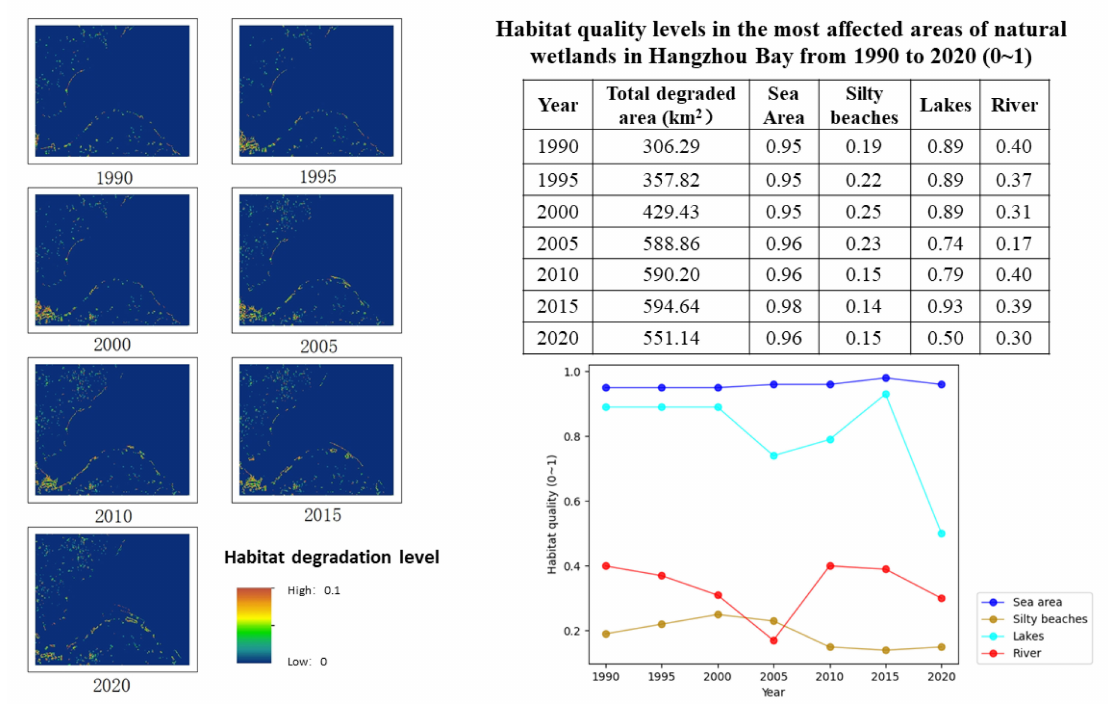
Figure 6. Habitat quality degradation distribution of the Hangzhou Bay wetlands from 1990 to